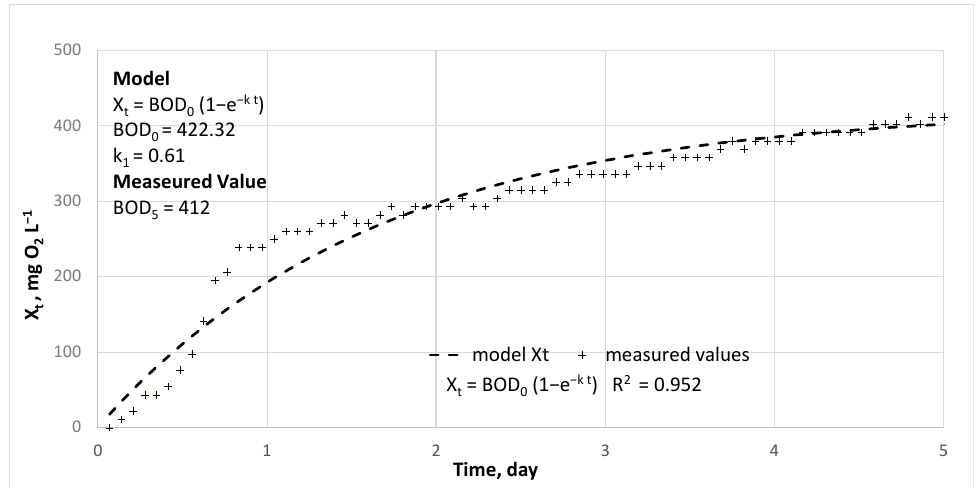
Figure 9. Value of biochemical oxygen consumption in rejected water, WWTP 3, sample 2. The mean values and the error and standard deviation of the reaction rate constants for all tested samples are presented in Figure 10.